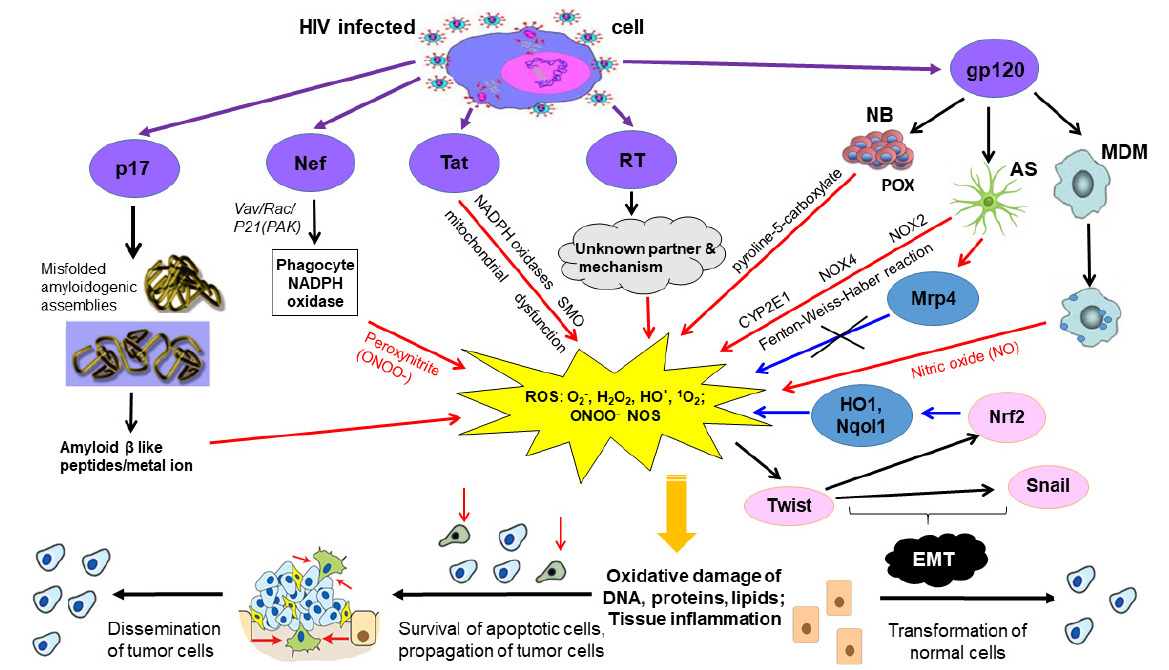
Figure 3. Suggestive mechanism of direct carcinogenic effects of HIV-1 proteins. HIV-1 infected cells express and release gp120, Tat, Nef, p17, RT, each capable of the induction of oxidative stress. (1) p17 may trigger the production of ROS through binding of redox active metal ions by its amyloidogenic assemblies [167]. (2) Nef may indirectly activate NADPH oxidase by activating the Vav/Rac/p21-activated kinase (PAK) signaling pathway involved in phagocytic NADPH oxidase activation and produce peroxynitrite [160]. (3) Tat induces oxidative action through several independent mechanisms via NADPH oxidase, spermine oxidase (SMO) induction and mitochondrial dysfunction [148]. (4) RT induces ROS through unknown mechanisms. There is ROS –dependent activation of the Twist [134], which regulates the expression of Nrf2, which stimulating the expression of antioxidant enzymes (HO1, Nqol1). In addition, the Twist regulates the expression of the Snail. Both transcription factors, Twist and Snail, are involved in epithelial to mesenchymal transduction (EMT). (5) Gp120 increases free radical production from monocyte-derived macrophages (MDM) inducing nitrogen oxide (NO). In astrocytes (AS), it enhances ROS production by several parallel mechanisms: via cytochrome P450 2E1 (CYP2E1), NOX2 and NOX4, and the Fenton-Weiss-Haber reaction. Multidrug resistance proteins (Mrps) involved in cellular defense against oxidative stress. Mrp4 (isoform of Mrp) involved in the regulation of ROS and it acts against ROS [156]. In neuroblastoma cells (NB) gp120 was shown to induce proline oxidase that produces pyroline-5-carboxylate with a concomitant generation of ROS [141]. Production of ROS, which damage of bystander cells inducing oxidative damage of DNA, proteins and lipids, apoptosis and inflammation. DNA damage drives genomic instability and promotes transformation of healthy cells, and propagation and dissemination of malignant cells [168]. Arrows indicate: purple arrows—secretion/entering the intercellular space; black arrows—relationships and interactions; red arrows—production of ROS; blue arrows—oxidative stress response. Text above arrows designates the processes leading to the production of ROS, and text below the arrows, forms of